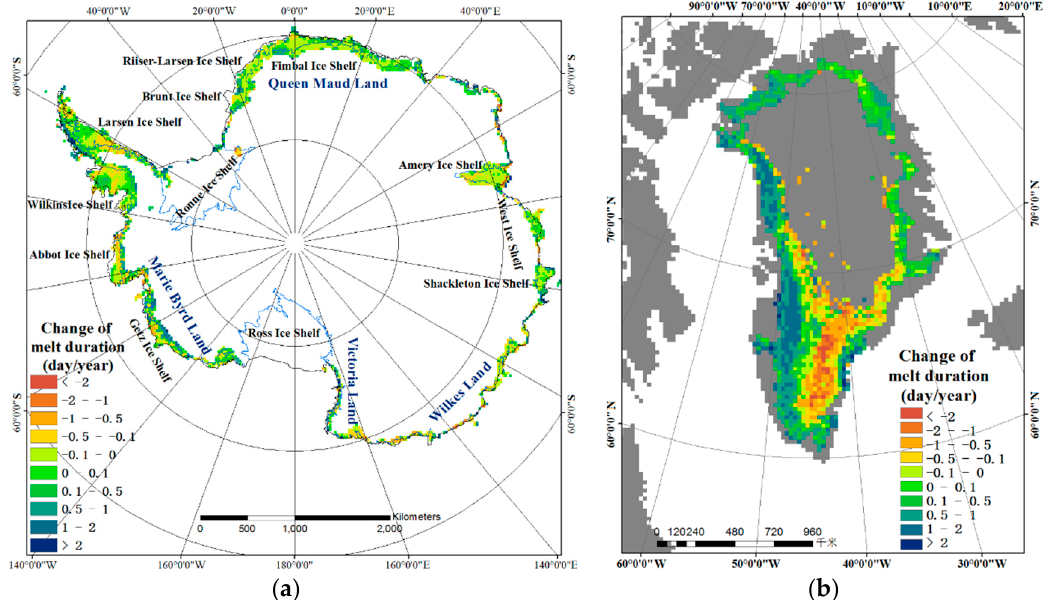
Figure 5. Distribution of the rate of change of the melt duration in ( a ) Antarctica and ( b ) Greenland during 1978–2014.